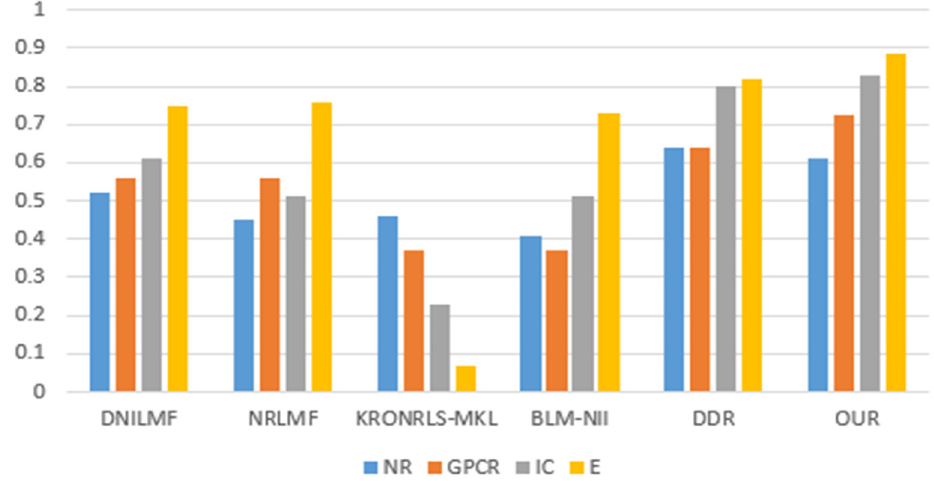
Figure 7. CVT partitioning of experimental results.